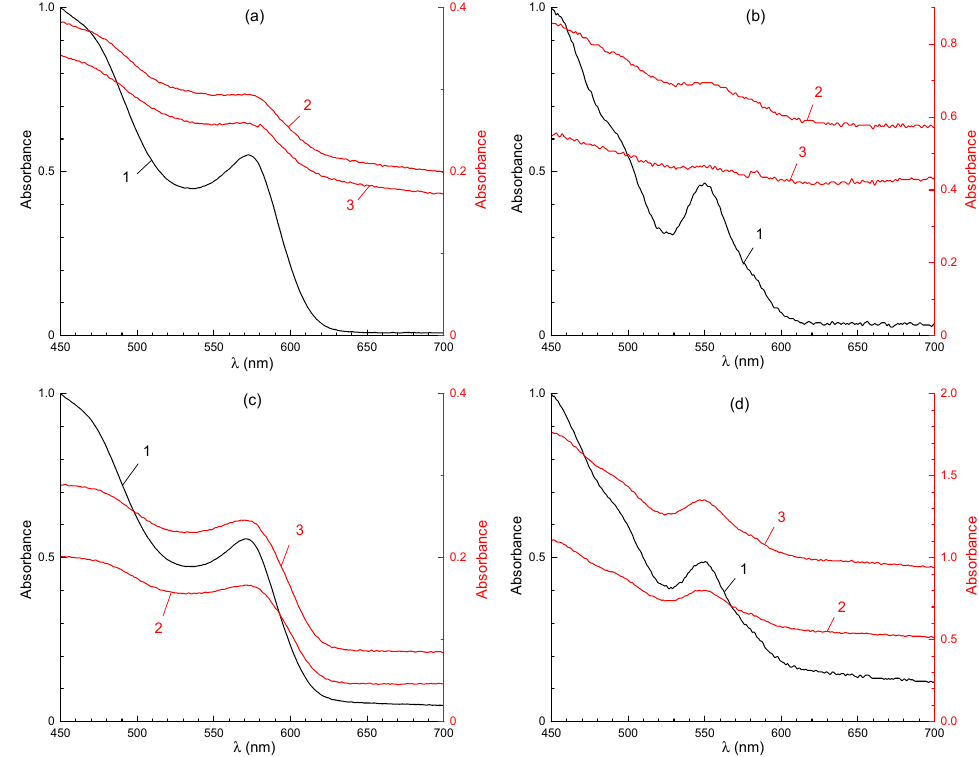
Figure 11. Absorption spectra for sols (1) and films before (2) and after annealing at 120 °C (3) of nanocomposites based on: M1 ( a , b ) containing CdSe ( a ) and CdSe/ZnS QDs ( b ); T1 ( c , d ) containing CdSe ( c ) and CdSe/ZnS QDs ( d ).